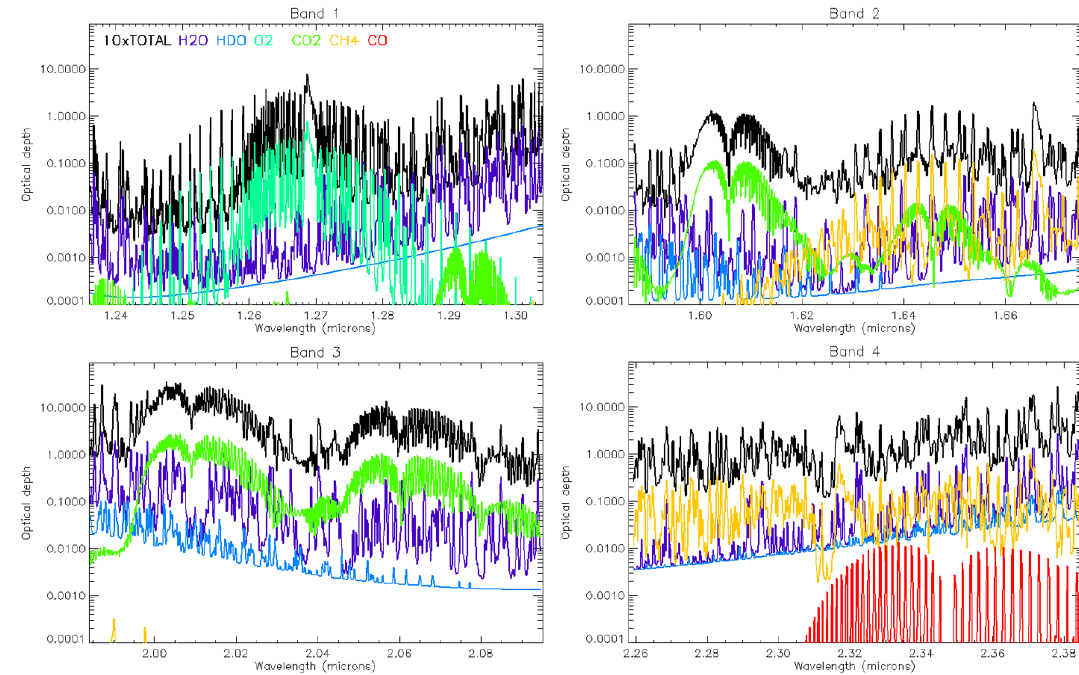
Figure 8. Optical depth spectra for each of the four GHOST spectral bands listed in Table 1, calculated assuming a midlatitude reference atmosphere and a viewing angle of 20 ◦ off nadir. The different colours correspond to the contributions towards the total optical depth from each species considered. The total optical depth spectrum for each band (shown in black) is multiplied by 10 to make it easier to see on the logarithmic